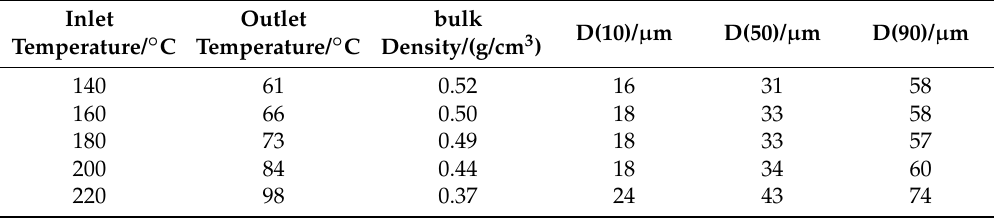
Table 1. Effect of inlet/outlet temperature on the bulk density and dimensions of the microspheres. Inlet